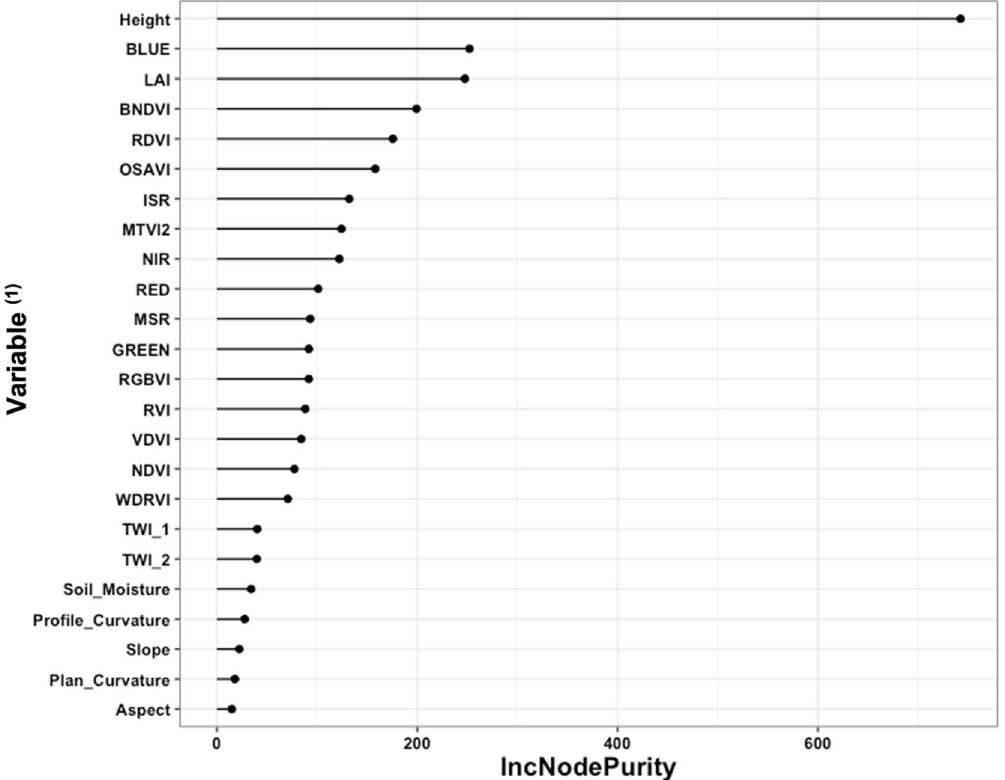
Figure 6. Variance Importance plot produced by the PlanetScope RF regression model of data from 12, 20, and 27 May and 24 variables, using the function varImpPlot() in RStudio. Higher IncNodePurity values indicate more impact on canopy nitrogen estimation. (1) Please refer to Table 1 for the full name of vegetation indices. TWI_1, total wetness index #1; TWI_2, total wetness index #2.